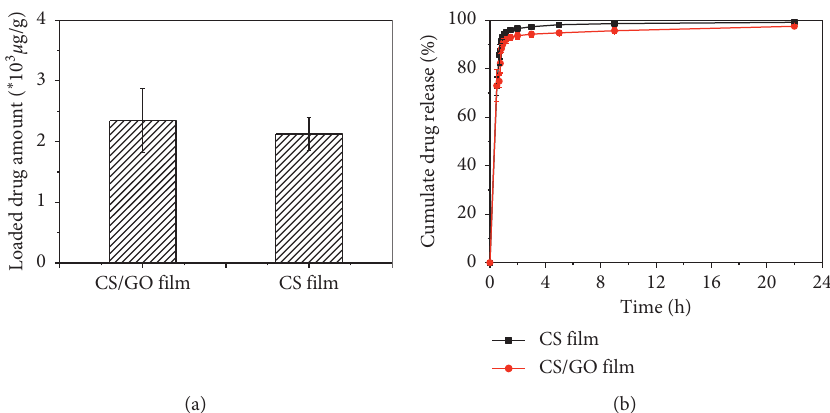
Figure 5: (a) Loaded drug amount of CS film and CS/GO film; (b) cumulative drug release of CS film and CS/GO film as a function of time. ∗ p < 0 . 05 and ∗∗ p < 0 . 01.